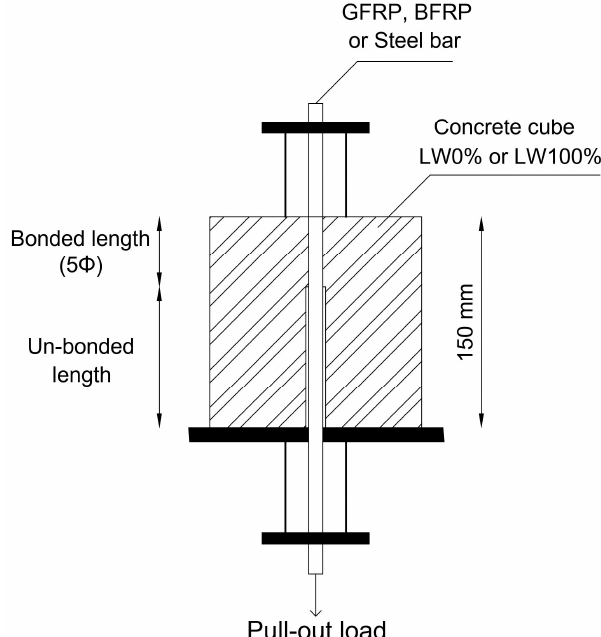
Figure 3. The dimensions and the test arrangement.